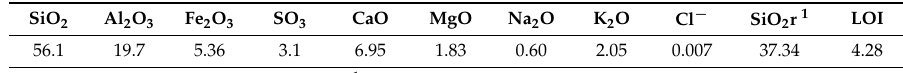
Table 1. Chemical composition of FA (mass%)